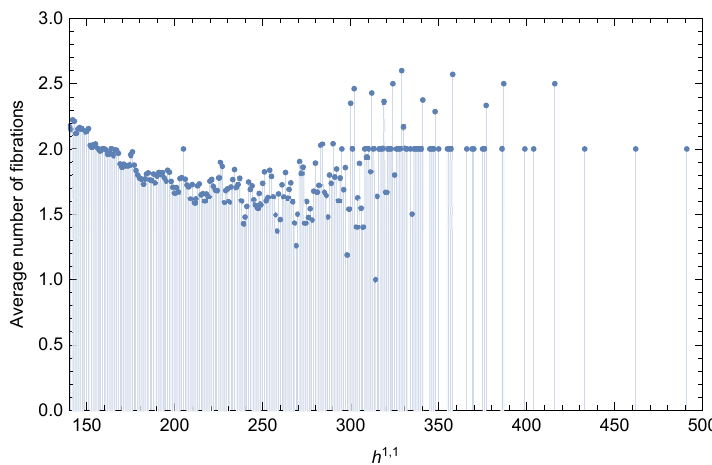
Figure 3 . Average number of (cid:12)brations for polytopes associated with Calabi-Yau threefolds with h 1 ; 1 (cid:21)